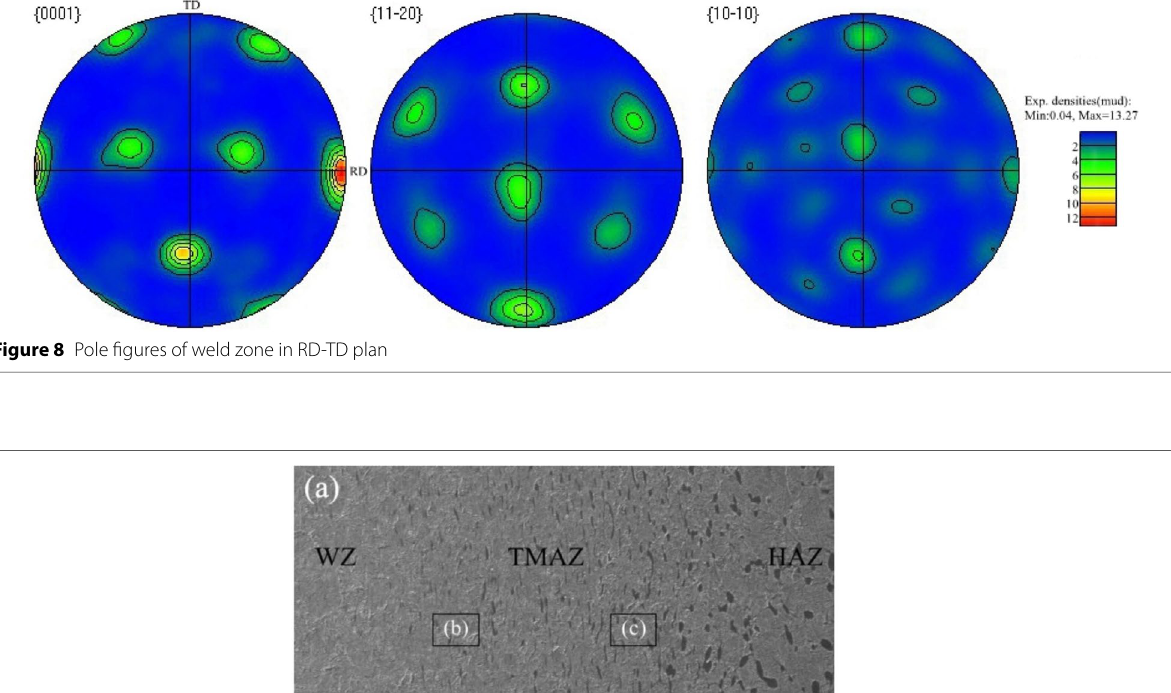
temperature close to WZ is much higher than that far